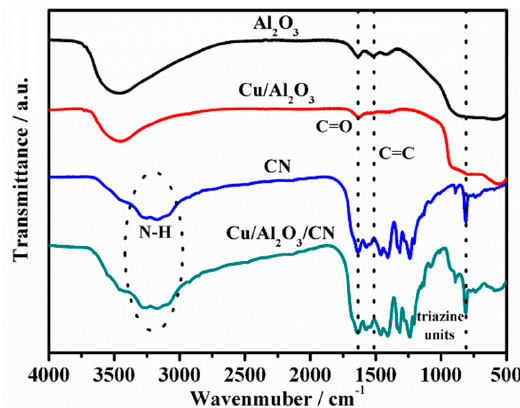
Figure 1. FT-IR spectra of Al 2 O 3 , Cu/Al 2 O 3 , CN, and Cu/Al 2 O 3 /CN samples.